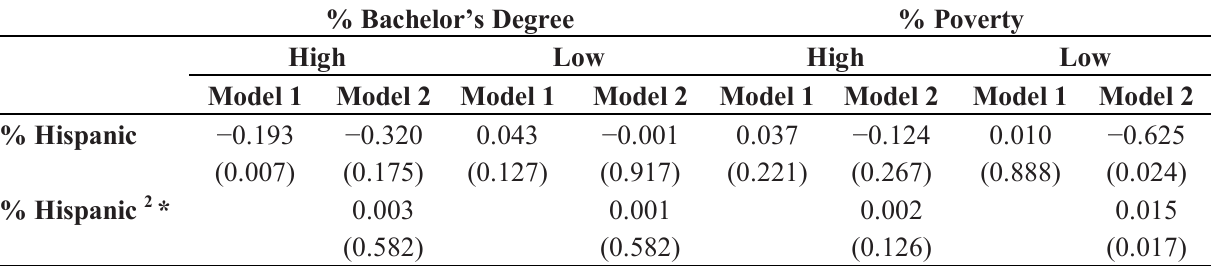
Table 4. Robust regression analysis results for county-level percent obesity stratified by high/low percent poverty and percent with bachelor’s degree †